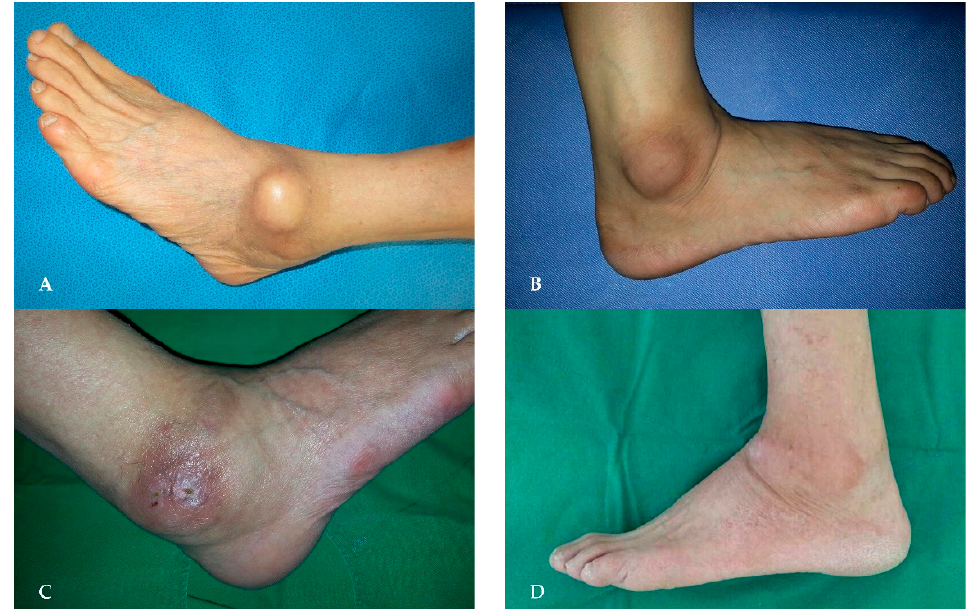
Figure 3. Cyst locations: ( A ) anterior to the lateral malleolus; ( B ) next to the lateral malleolus; ( C ) posterior to the lateral malleolus; ( D ) across the entire lateral malleolus.